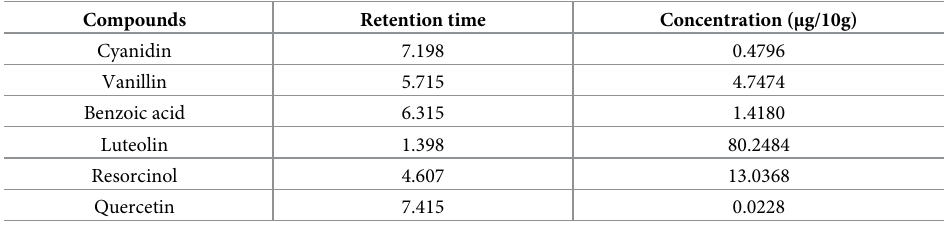
Table 1. Bioactive compounds identified in